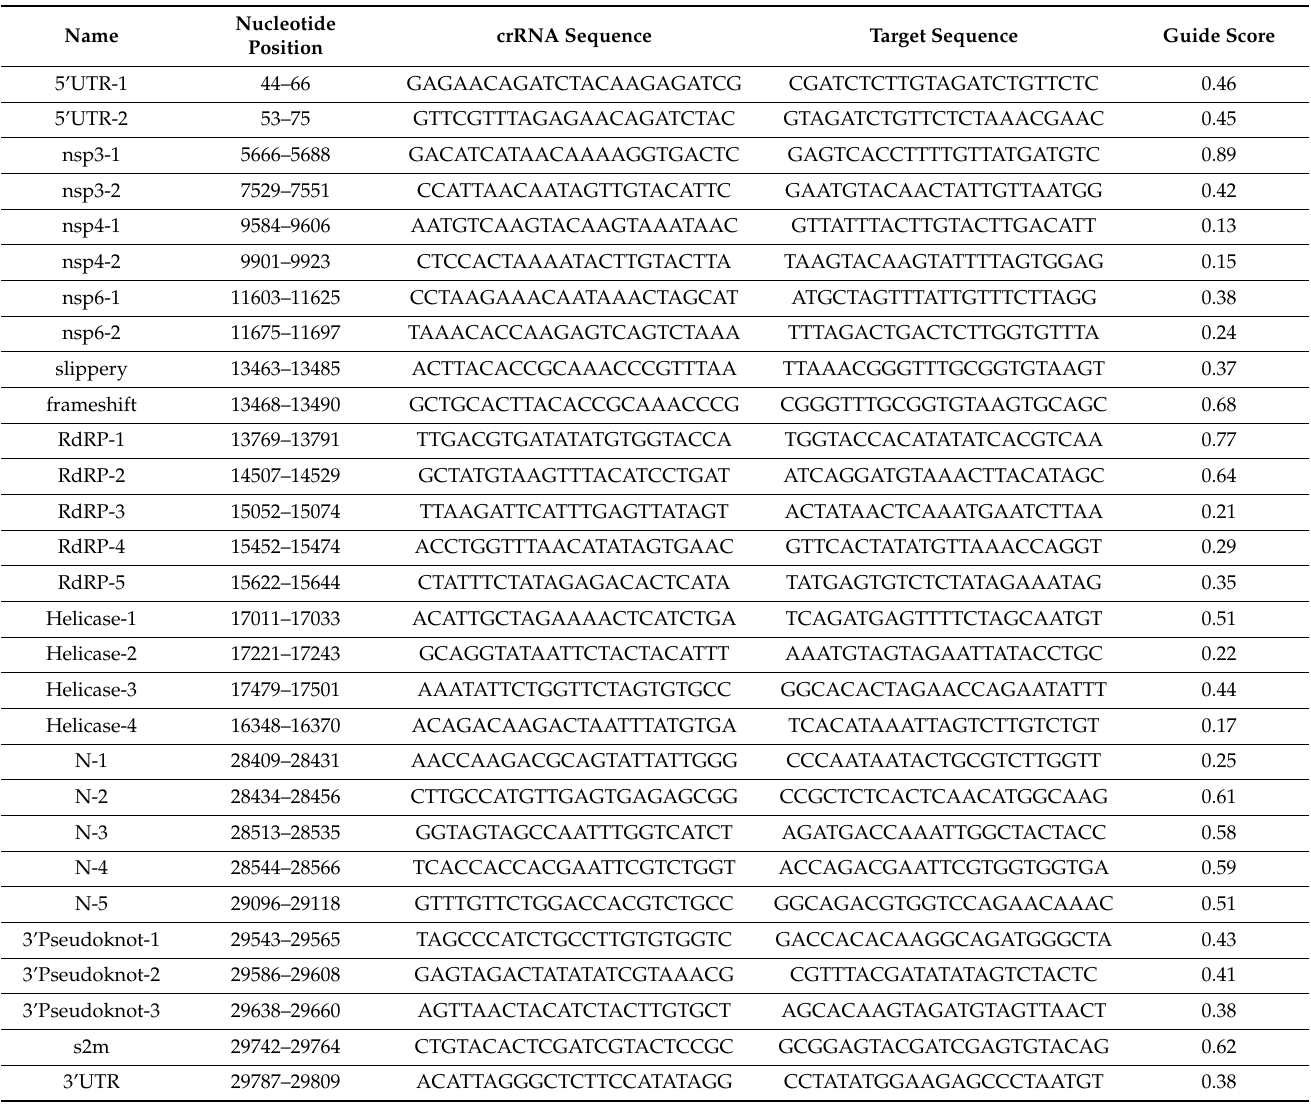
Table 1. crRNAs targeting SARS-CoV-2